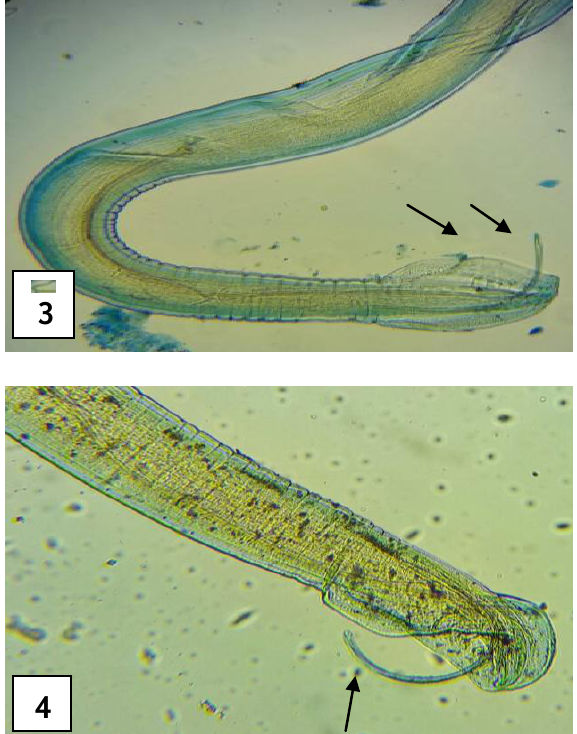
Figure, 3 and 4: Posterior end of the male with appearance of the spicules and the excretory pore respectively (x20).